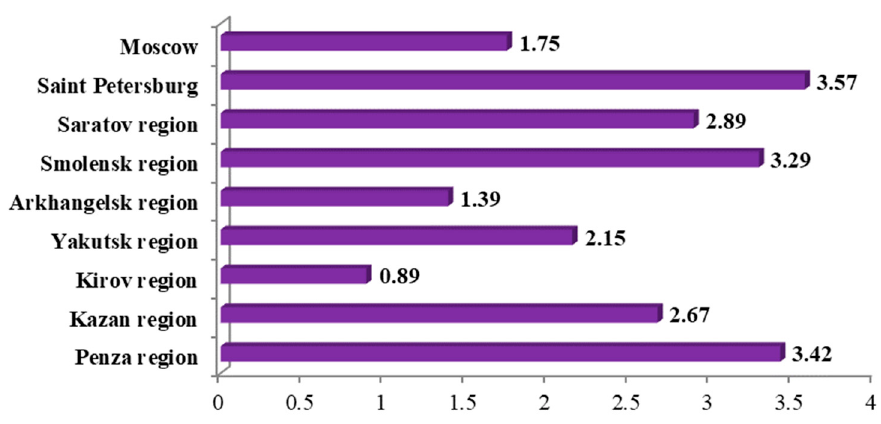
Figure 5. Lethality because of SARS-CoV-2 at the time of the study.